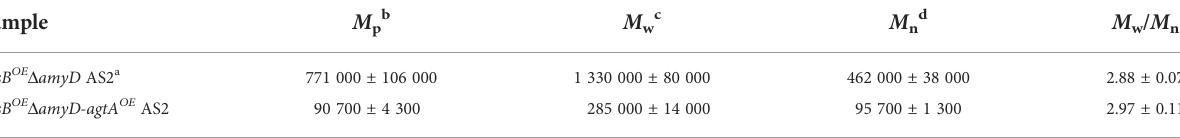
TABLE 4 Molecular weight of alkali-soluble glucan from the cell wall. Sample